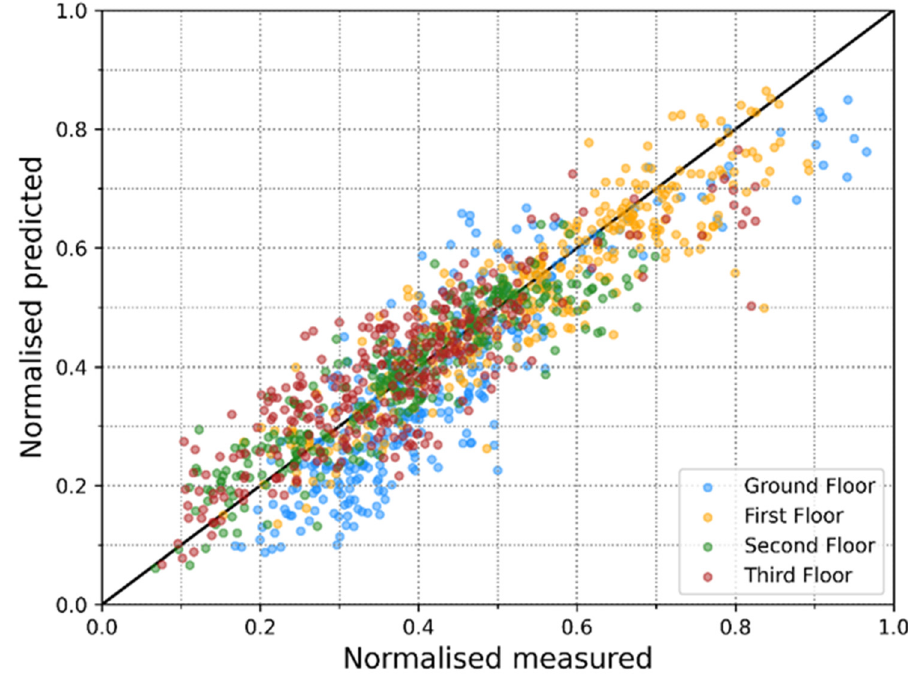
Figure 7. Normalized dispersion of the results.